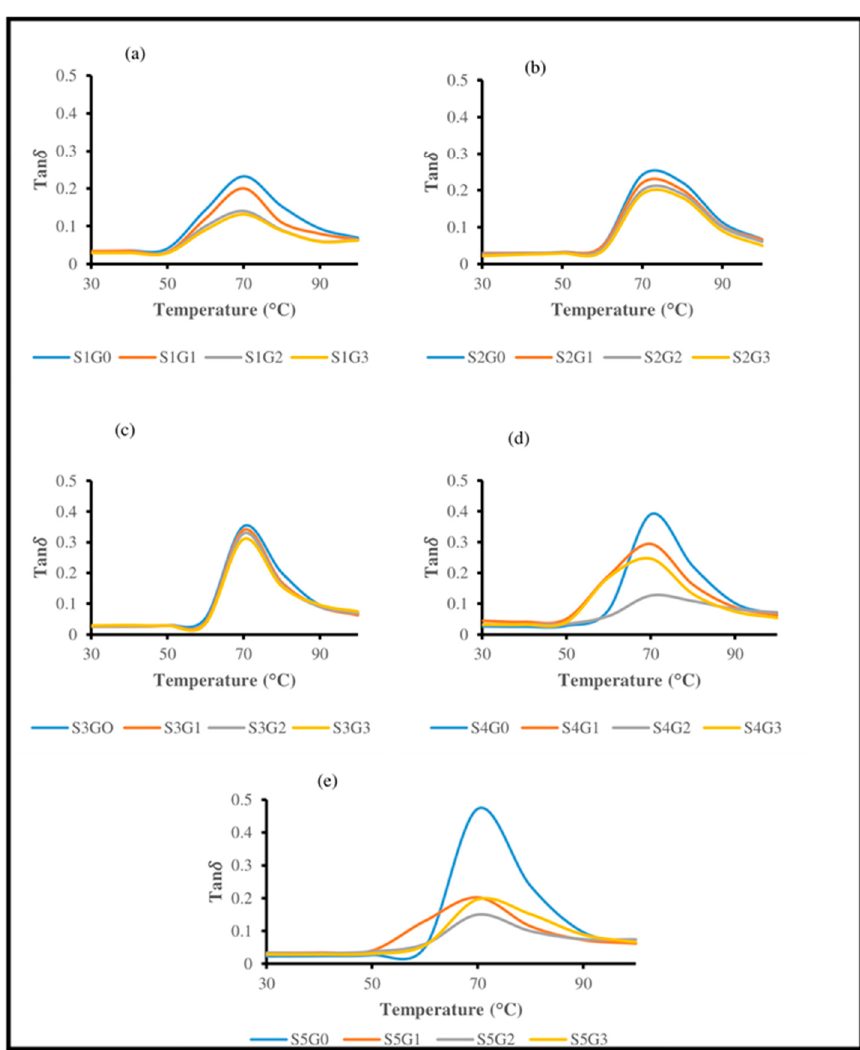
Figure 9. E ff ect of GNP on Tan δ plot of laminated composites. ( a ) S1, ( b ) S2, ( c ) S3, ( d ) S4, ( e )